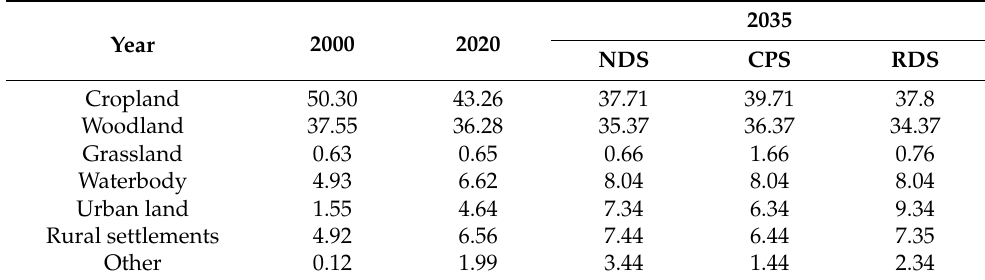
Table 3. Area ratio of different land use types in Deqing in 2000 and 2020 and the area demand ratio for 2035 under different scenarios